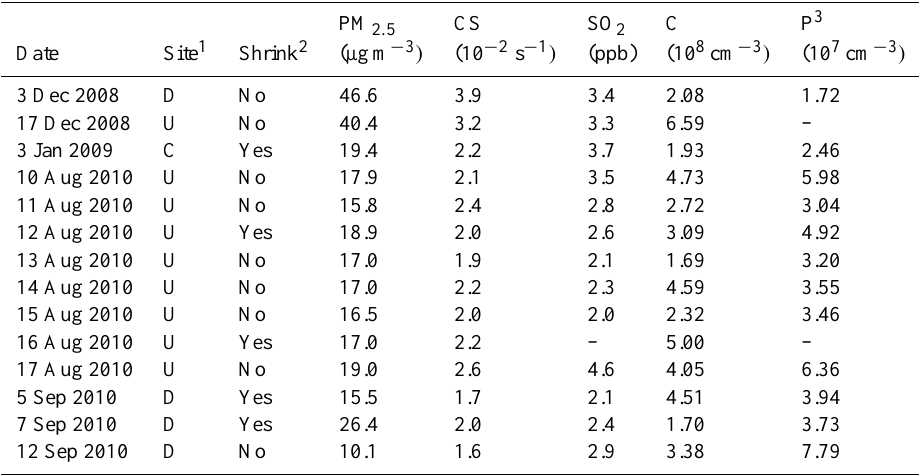
Table 2. The daily averages of PM 2 . 5 , condensation sink (CS), SO 2 , condensable vapor (C) and H 2 SO 4 proxy (P) concentrations during the NPF event days.